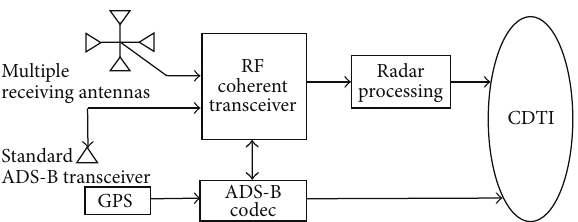
Figure 2: Conceptual architecture of ADS-B radar